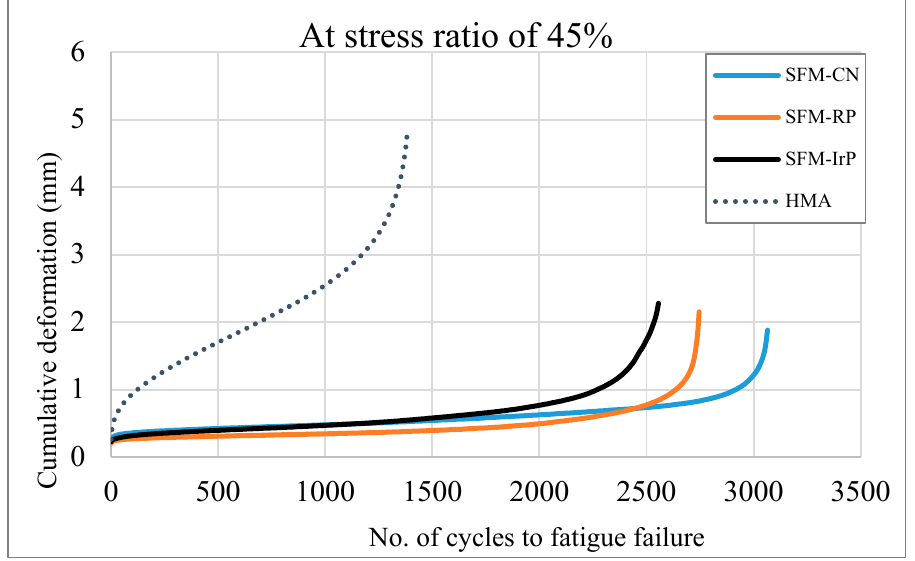
Figure 13. The relationship between cumulative deformation and the number of cycles to fatigue failure at a 45% stress ratio .